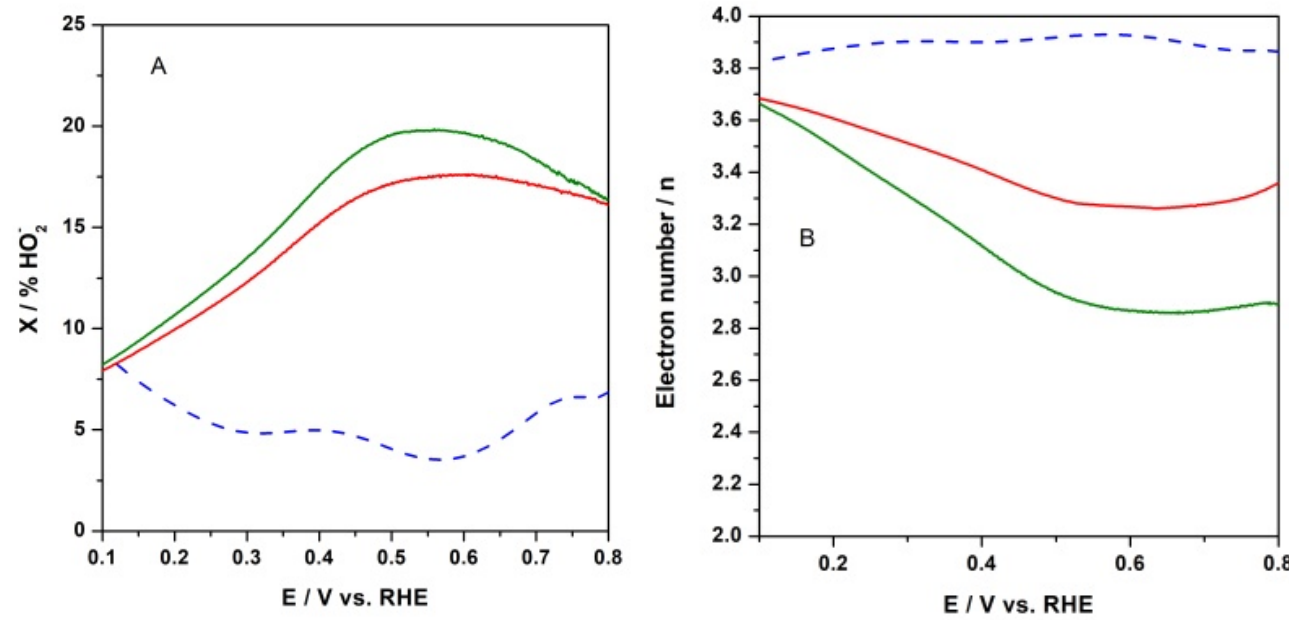
Figure 10. ( A ) Percent fraction of peroxide anion (X% HO 2 − ) formed during electroreduction of oxygen at CFeN@rGO-COOH in (a) the absence (solid green curve) and (b) the presence (solid red curve) of an external magnetic field, and Pt/C nanoparticles (dash blue curve) under the conditions of RRDE voltametric experiment. ( B ) Numbers of transferred electrons (n) per oxygen molecule during electroreduction of oxygen under conditions described above.